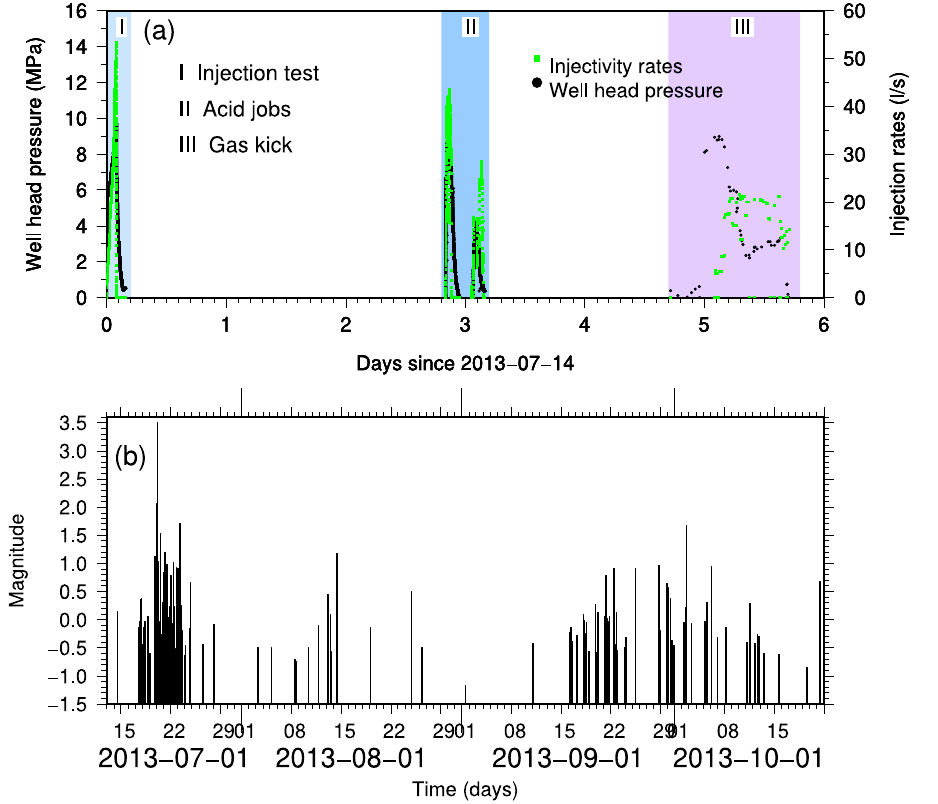
Figure 3. Injection rate and seismicity evolution for St. Gallen. ( a ) Well head pressure (black dots) and injection rates (green dots) during the different phases of the project as reported by Moeck et al. 16 . ( b ) Temporal distribution of the seismicity recorded at St. Gallen geothermal field.